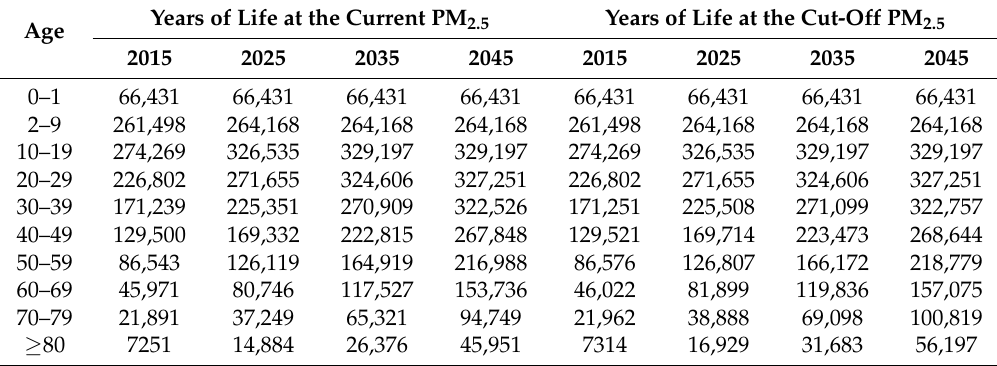
Table 7. Sensitivity analysis for YLL and premature mortality for different age groups. Years of Life at the Current PM 2.5 Years of Life at the Cut-Off PM 2.5 Age